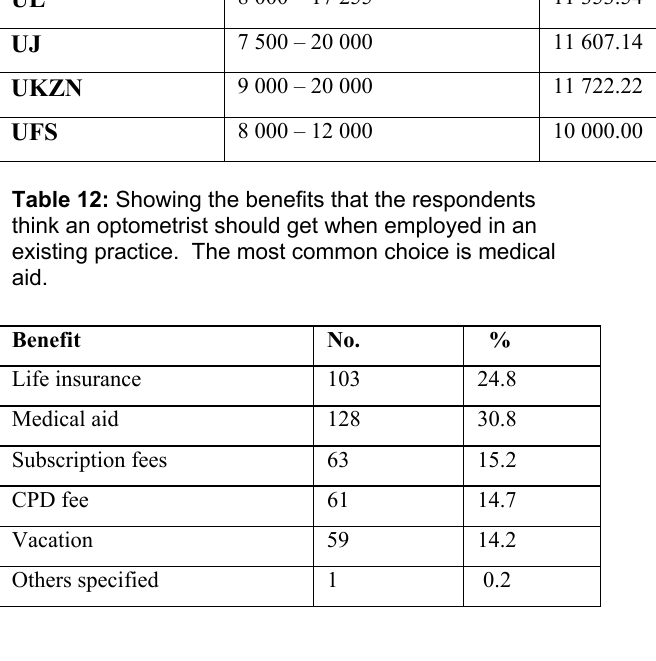
Table 13: The countries where the respondents would like to go and practice. Many of them prefer the United Kingdom (UK). ‘Others’ in the table refer to Dubai, Germany, Namibia and Ireland. Country